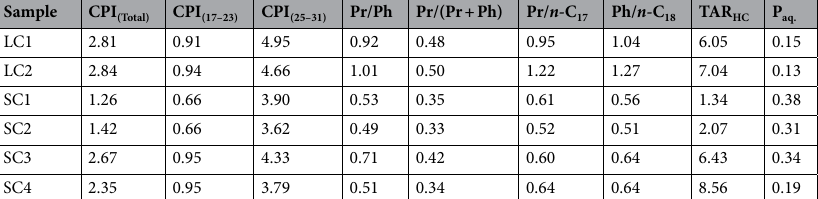
Table 3. Biomarker indicators of origin of organic matter and palaeoenvironment conditions. CPI Carbon Preference Index, Pr pristine, Ph phytane, TAR HC Terrigenous-Aquatic Ratio, P aq. terrestrial/aquatic plants in aquatic environments, counted as ( n -C 23 + n -C 25 )/( n -C 23 + n -C 25 + n -C 29 + n -C 31 ).